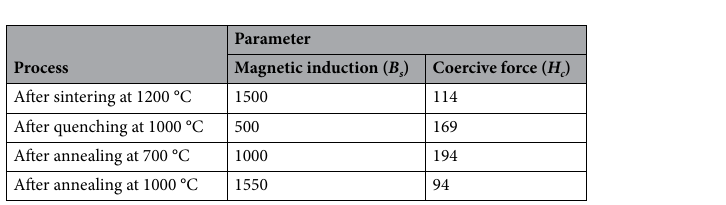
Table 2. The magnetic induction, B s and coercive force, H c after sintering, quenching and after annealing.